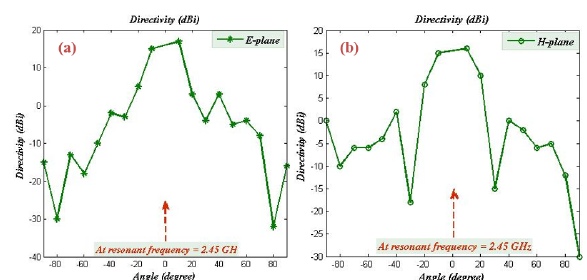
Fig. 11. The directivity versus frequency for 1 st , 2 nd and 3 rd - orders dipole antenna filter